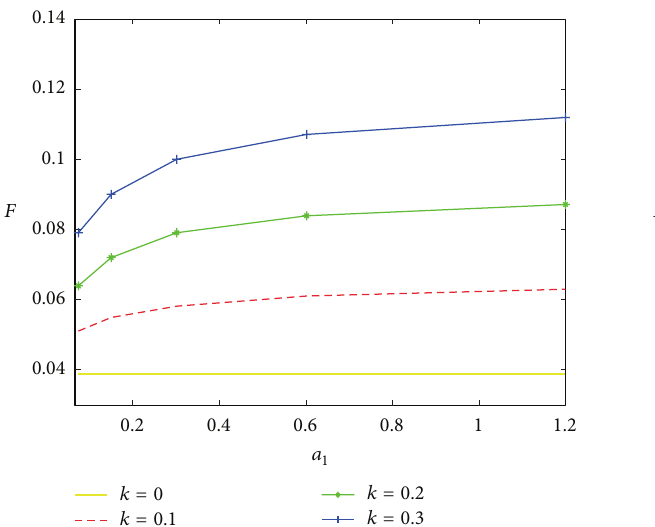
Figure 7: Impact of 𝑏 1 on sampling